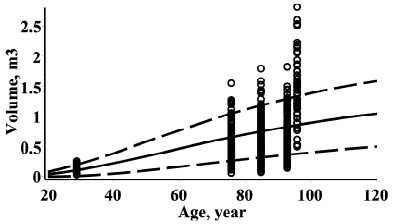
Figure 5. Mean stem volume and its standard deviation: mean stem volume—solid line; mean stem volume ± standard deviation—dash line; observed stem volumes—circles.